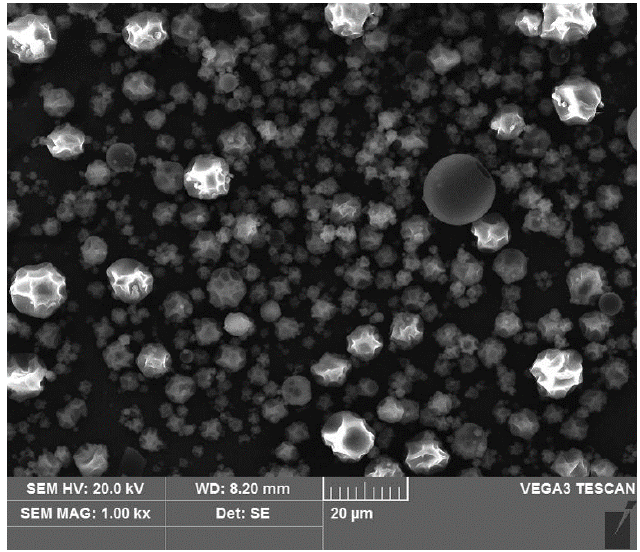
Figure 1. Scanning electron microscope (SEM) images of microcapsules produced by ferulic acid-grafted altodextrin.